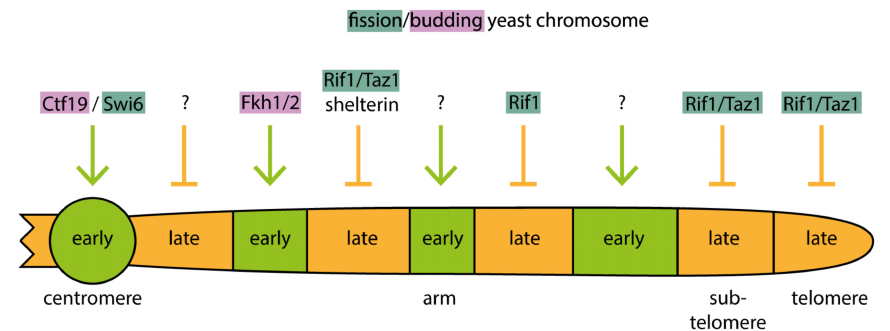
Figure 4. Origin firing pathways that control replication timing of yeast chromosomes. Work in fission and budding yeast has revealed several molecular pathways that determine whether a chromosomal region replicates early (green) or late (orange). Ctf19/Swi6 promotes early replication of the centromere, while Fkh1/2 are involved in the early replication of some regions of the chromosome arm. Rif1 and/or Taz1 and/or shelterin dependent regulations ensure the late replication timing of the telomeric, sub-telomeric and some chromosomal arm regions. Other uncharacterised mechanisms for early or late replication timing regulations exist and are indicated with a question